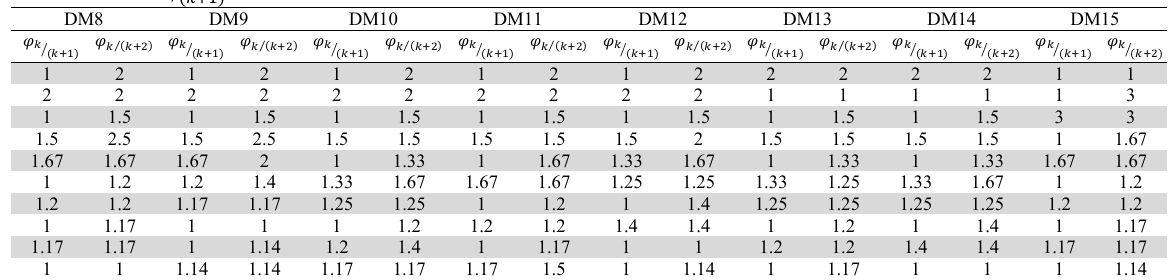
and 𝜑 (cid:3038) ( (cid:3038)(cid:2878)(cid:2870) ) ( (cid:3038)(cid:2878)(cid:2869) ) (cid:3415)